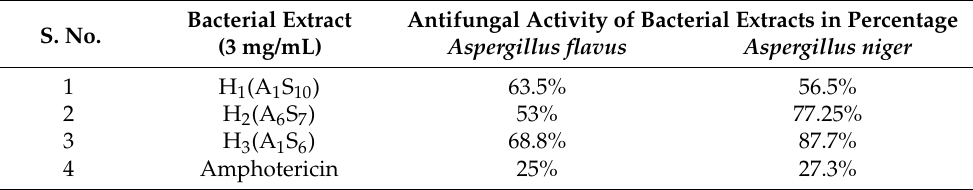
Table 4. Antifungal activity of bacterial extracts (3 mg/mL) against pathogenic fungal species. S. No.